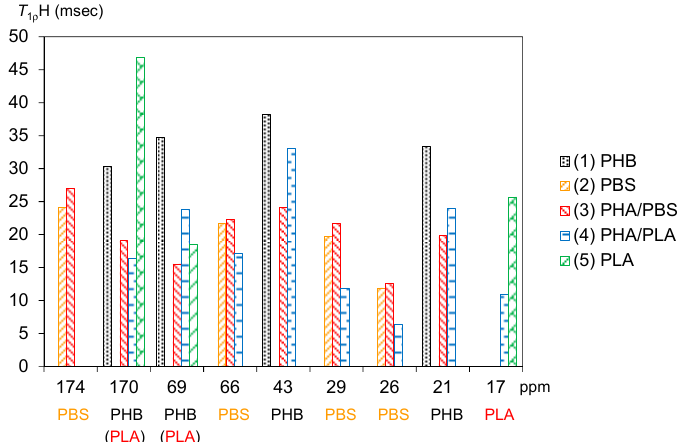
Figure 6. Changes of T 1 ρ H values with copolymerization. The horizontal axis shows the chemical shift of each signal appearing in the 13 C CP-MAS NMR spectra while the vertical axis shows the corresponding T 1 ρ H value.